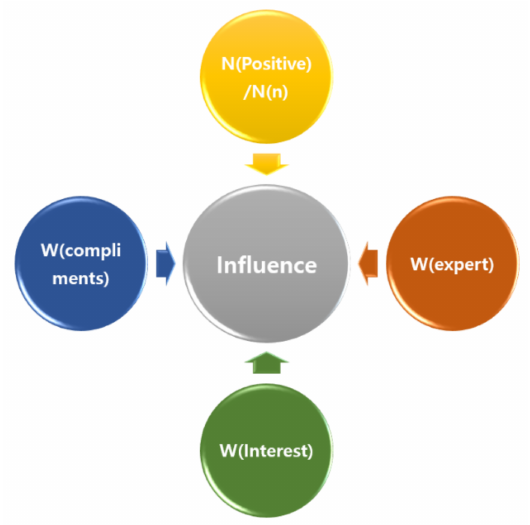
Figure 1. Elements of